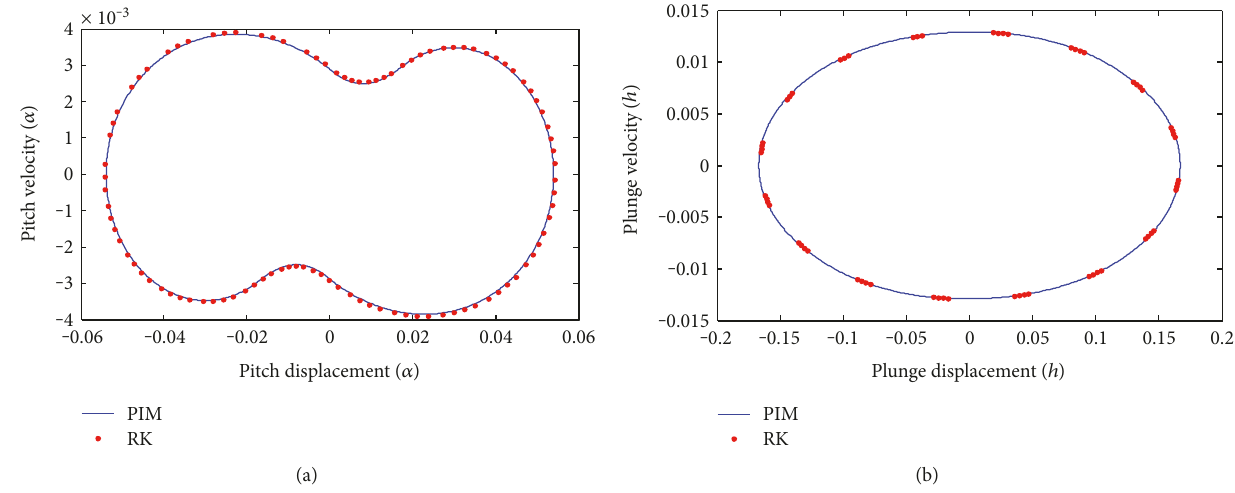
Figure 7: Phase planes of LCOs for (a) pitch and (b) plunge directions, respectively, at U / U